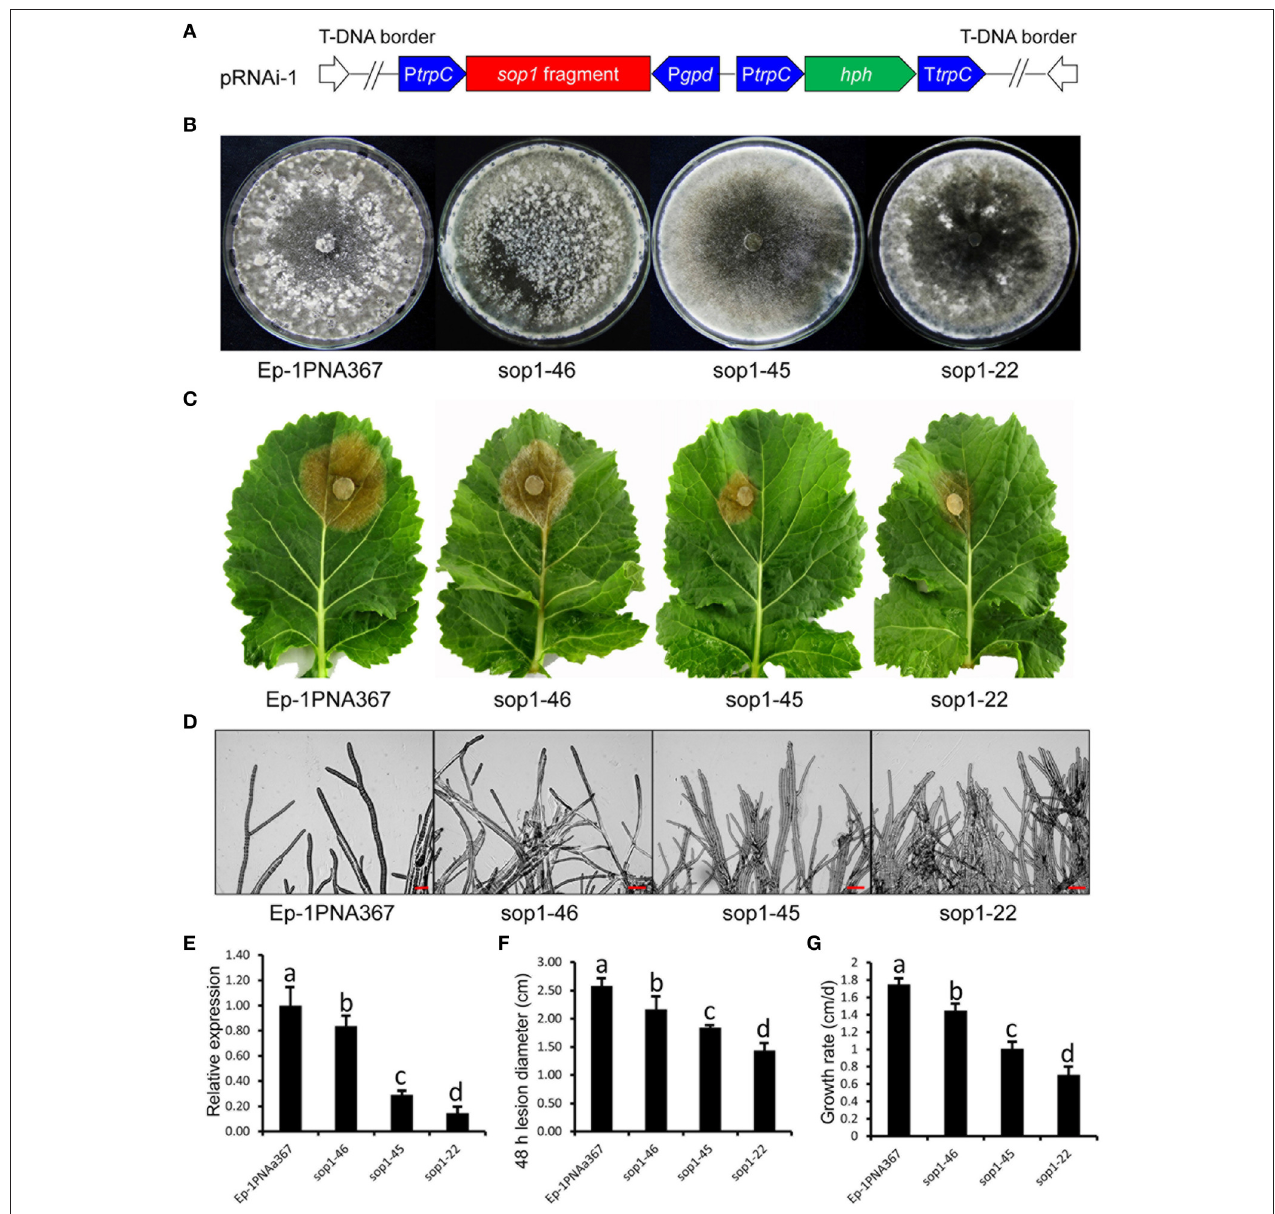
FIGURE 3 | Biological characterization of the sop1 silenced transformants. (A) Construction of sop1 silencing vector pRNAi-1. (B) Comparison of the phenotypes of the sop1 silenced transformants and the wild-type strain. Photos were taken at 8 dpi. (C) Virulence assay of the silenced transformants and the wild-type strain on detached oilseed rape leaves. (D) Morphological comparison of the hyphal tips of the sop1 silenced transformants and the wild-type strain. (E) Relative sop1 expression level of the sop1 silenced transformants and the wild-type strain as determined by qRT-PCR analysis. A value of 1 was assigned to the abundance of cDNA from the wild-type strain. The gene expression levels of sop1 in the silenced transformants and the wild-type strain were normalized to that of the β -tubulin transcripts from each strain. Bars indicate the standard error. (F) Comparison of lesion diameter for the silenced transformants and the wild-type strain. (G) Comparison of the hyphal growth rate of the silenced transformants and the wild-type strain. Three independent replications were performed. Bars indicate the standard error. The values are presented as the mean ± s.d. Differentiation was evaluated by a t -test. Different letters on a graph indicate significant differences, while same letters on a graph indicate no significant differences, P = 0